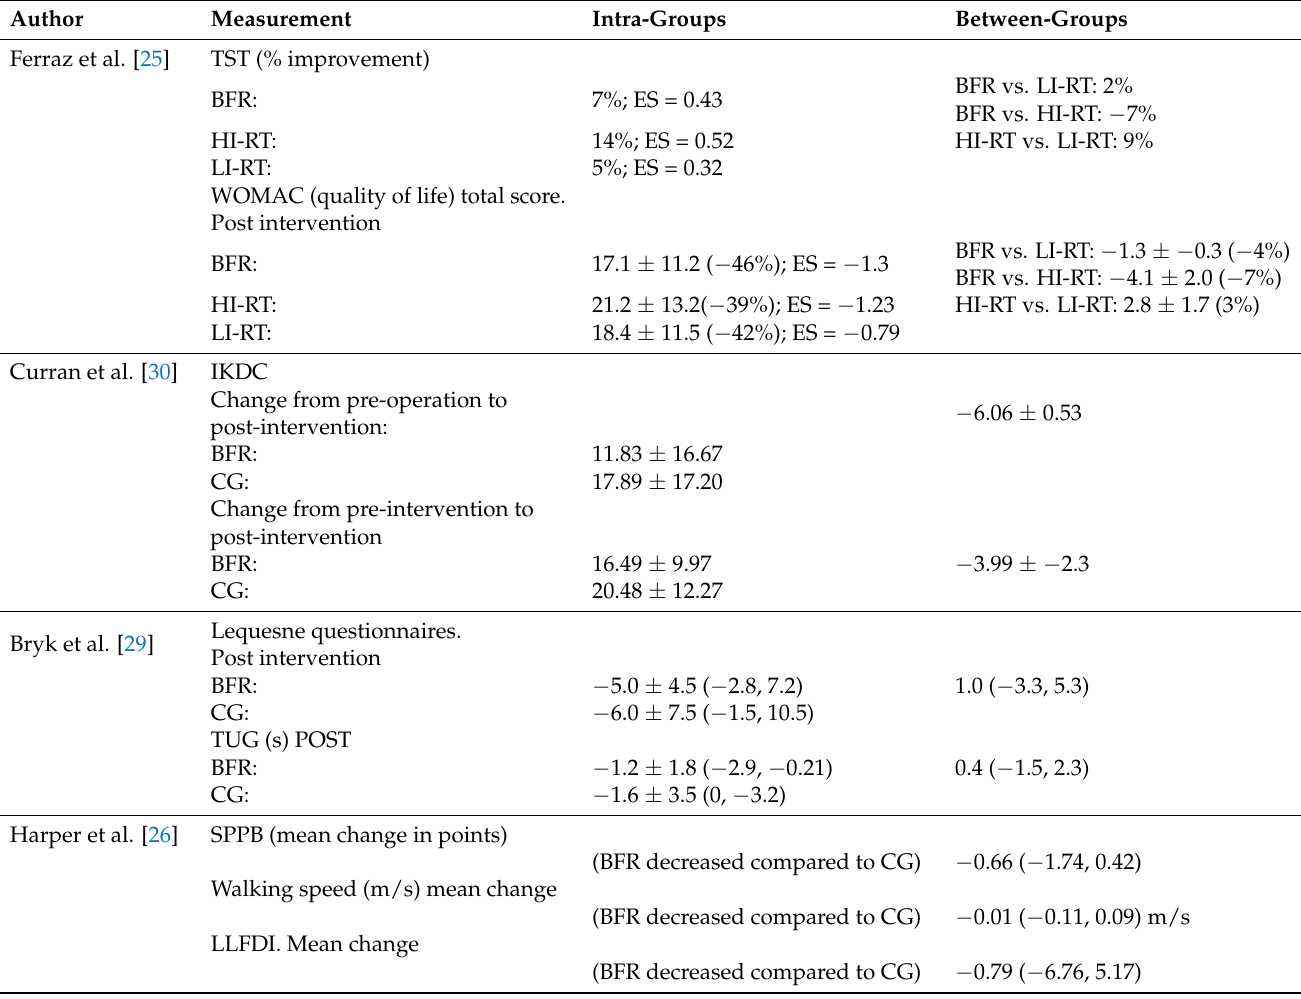
Table 4. Function and/or quality of life